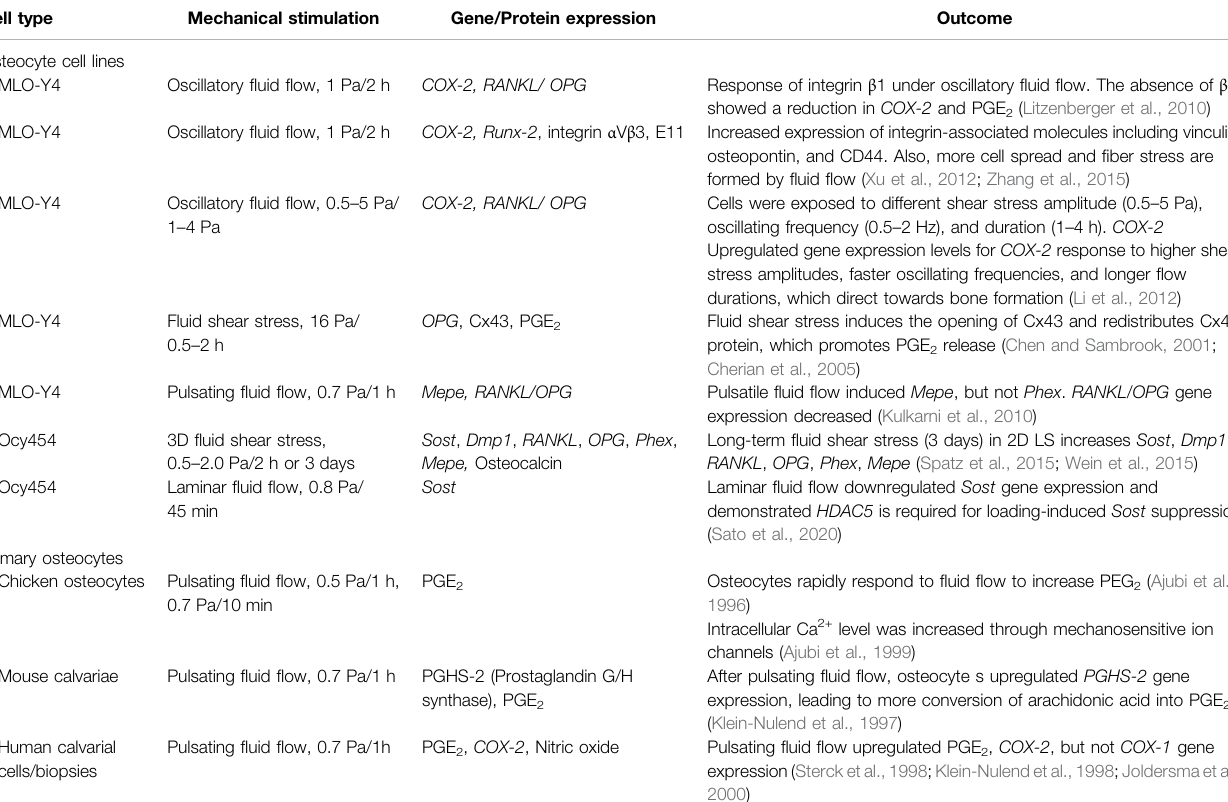
TABLE 1 | Summary table for in vitro studies on osteocytes in response to mechanical stimulations. Abbreviations: Sclerostin ( Sost ), cyclooxygenase-1 ( COX-1 ), osteoprotegerin ( OPG ), receptor activator of nuclear factor- κ B ligand ( RANKL ), podoplanin ( E11 ), prostaglandin E2 (PGE 2 ), cyclooxygenase-2 ( COX-2 ), connexin 43 (Cx43), matrix extracellular phosphoglycoprotein ( Mepe ), phosphate regulating endopeptidase homologue, X-linked ( Phex ), dentin matrix protein 1 ( Dmp1 ). Cell